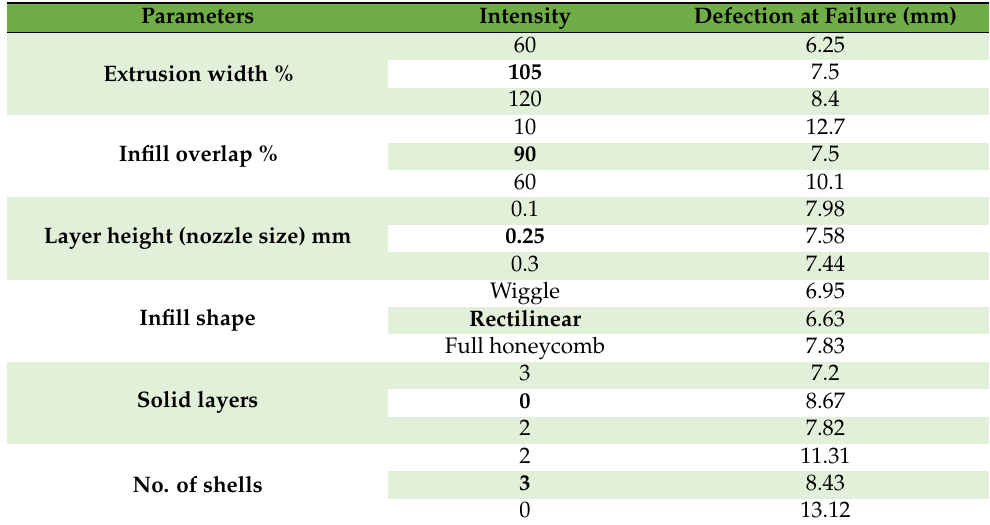
Table 1. Optimized layer design parameters using multiscale modeling for three intensities, in which the one in bold is chosen as the optimum intensity.